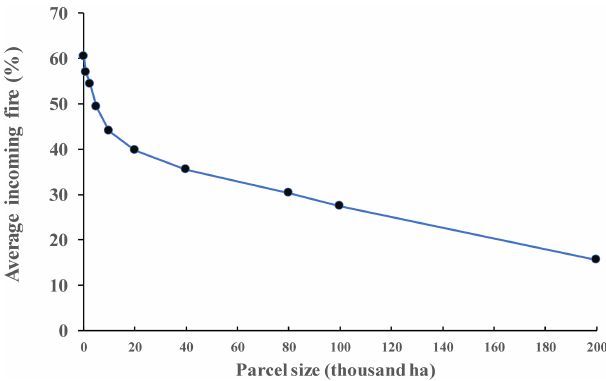
Figure 6. Relationship between parcel size and average percentage of incoming